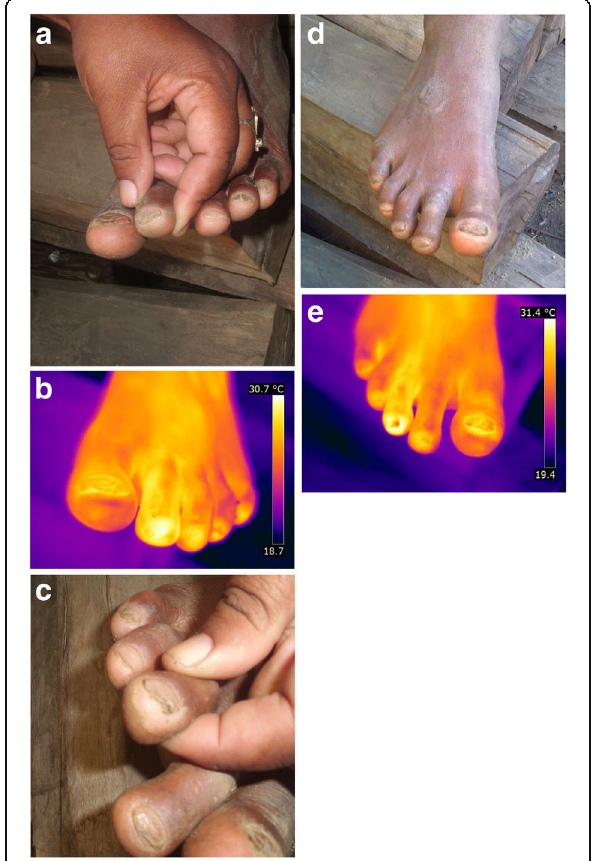
Fig. 2 ( a ) left foot with stage IIIa lesion and with periungual edema. ( b ) left foot, hyperthermic areas on all toes (iron transformation). ( c ) right foot whit 2 stage II lesions with suppurated and uplifted nail. ( d ) right foot overview with hypertrophic nails and oedematous